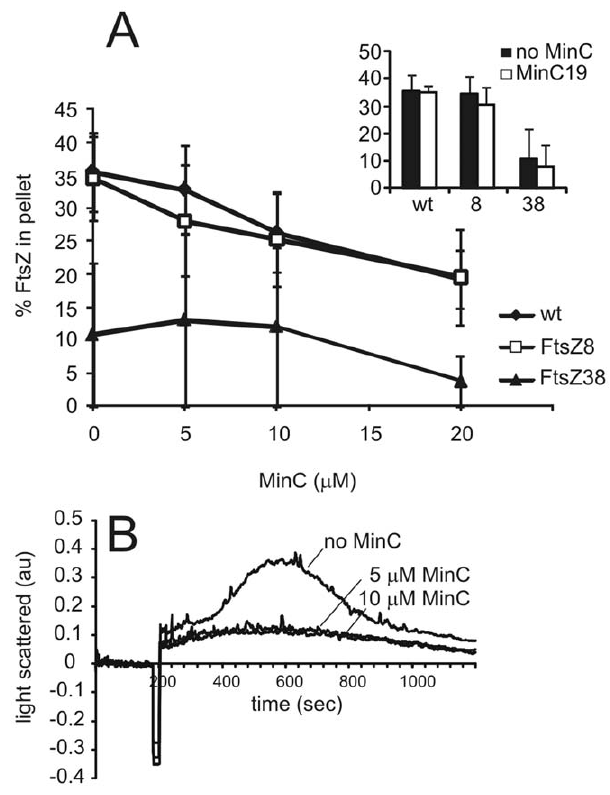
Figure 3. FtsZ8 and FtsZ38 are still sensitive to MinC. (A) Polymerization of FtsZ, FtsZ8 and FtsZ38 (10 m M) was determined in the presence of MinC at various concentrations (x-axis) by sedimentation as described for Fig. 2A. In this experiment, background sedimentation with GDP was subtracted to plot only GTP-dependent sedimentation of polymers. Inset: control experiment where polymerization was deter- mined in the presence of the less active MinC19 mutant (20 m M). Mean 6 SD from three independent experiments are shown. (B) FtsZ8 (10 m M) polymerization monitored by light scattering with MinC at concentrations indicated. The experiment was performed identical to the description in Fig 2B, the trace in the absence of MinC is duplicated – note the difference in